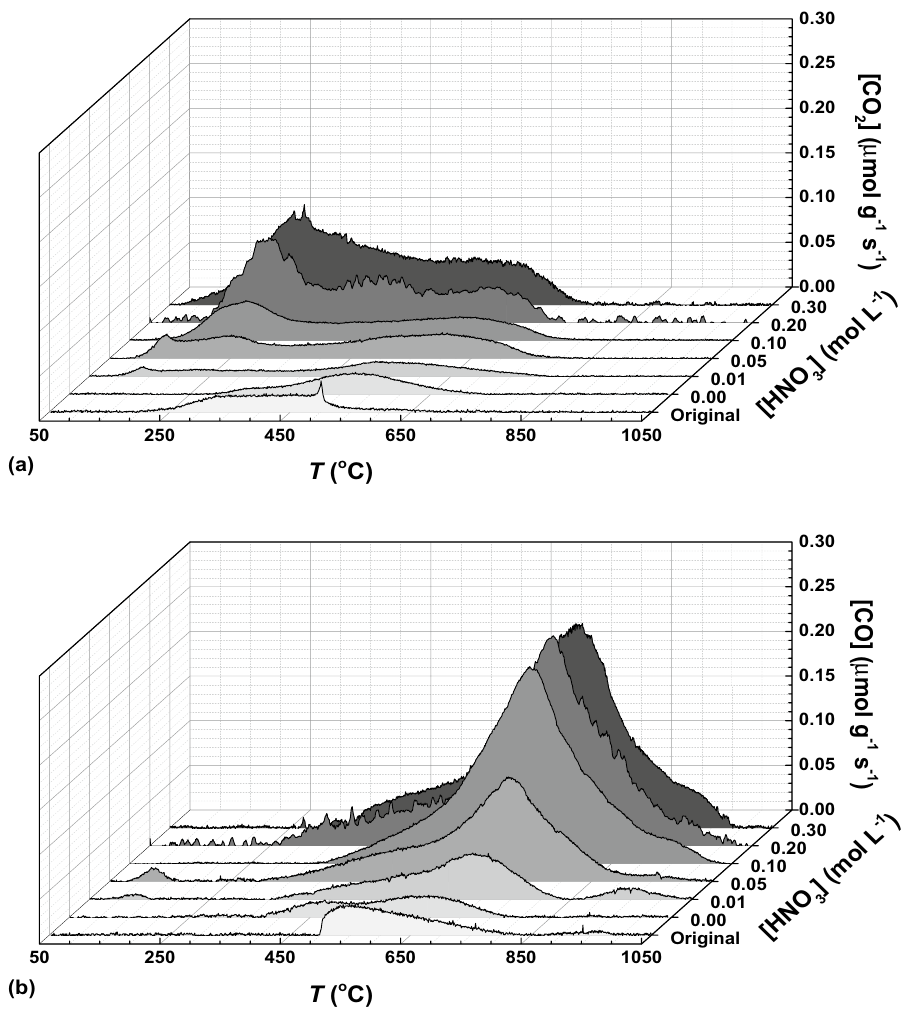
Figure 2. TPD spectra of MWCNTs subjected to hydrothermal treatment with different HNO 3 concentrations: (a) CO 2 and (b) CO evolution with temperature.